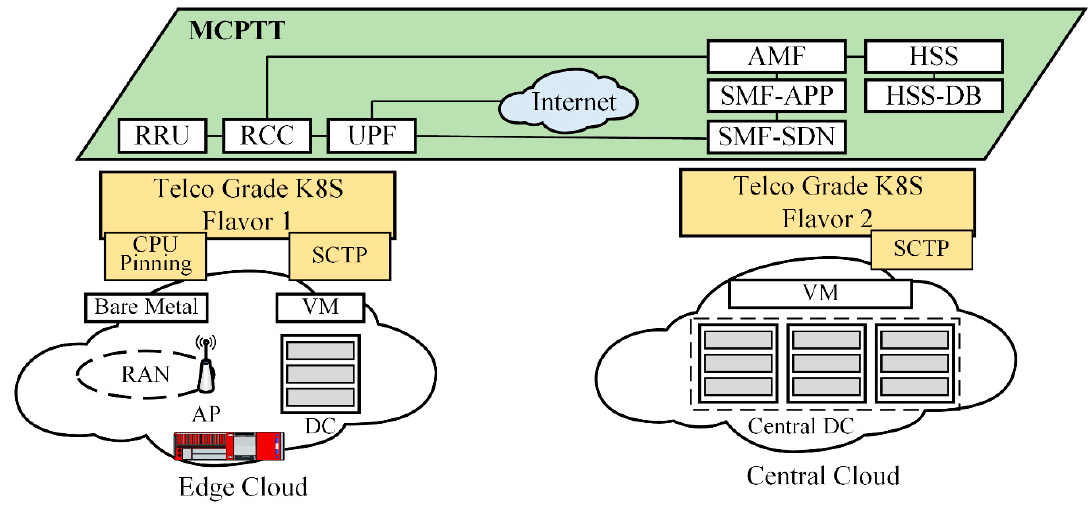
Figure 16. The 5G Public Safety Use Case.